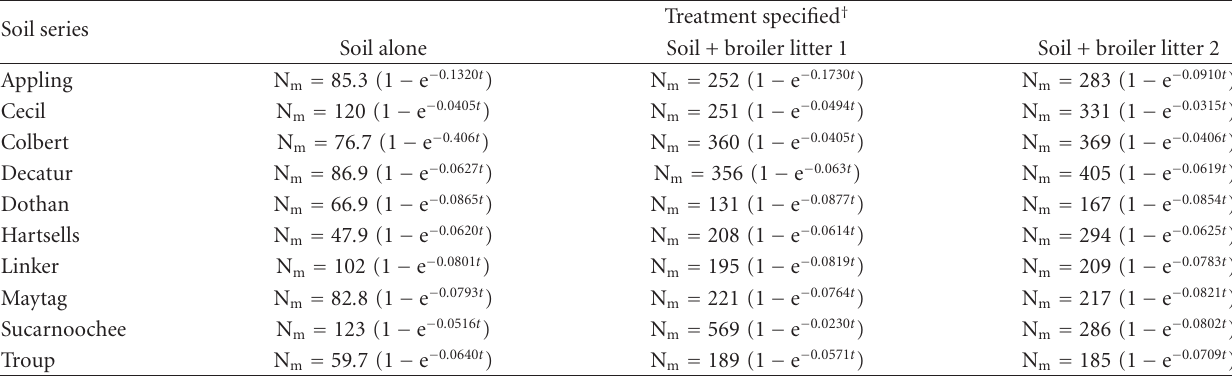
Table 4: Regression equations (for curves in Figures 1–5) for organic N mineralized in selected Alabama soils. Soil series